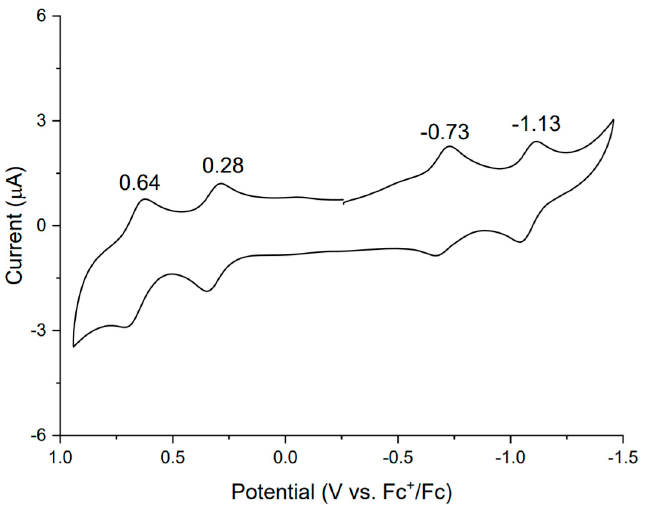
Figure 5. Cyclic voltammogram of 3 in TBAPF 6 [0.1 M] in CH 2 Cl 2 with scanning rate of 100 mV/s. 3. Materials and Methods All commercially available reagents and compounds were used as received without further purification. Naphthobipyrrole moiety was synthesized according to a literature procedure [20]. All solvents were dried and distilled before going to use. All the reactions, which are sensitive to moisture or oxygen were performed under a nitrogen atmosphere. The thin layer chromatography was performed on aluminum backed silica gel 60 F254 (Merck) or neutral alumina F254 (Sigma ‐ Aldrich) (Darmstadt, Germany). Product purifi ‐ cation was performed by column chromatography on silica (230–400 mesh, MN) or neu ‐ tral aluminum oxide 90 (70–230 mesh, Merck). Synthesized compounds identity and pu ‐ rity was confirmed by using 400/ 600 NMR spectroscopy (Carnation, WA, USA). Jeol 400MHz was used to check 1 H ‐ NMR, variable NMR study and TFA titrations. For 13 C ‐ NMR spectroscopy Bruker 600 MHz was used. Mass spectral data were obtained by Voy ‐ ager DE ‐ STR MALDI ‐ TOF (Foster City, CA, USA). Absorption spectra were recorded with